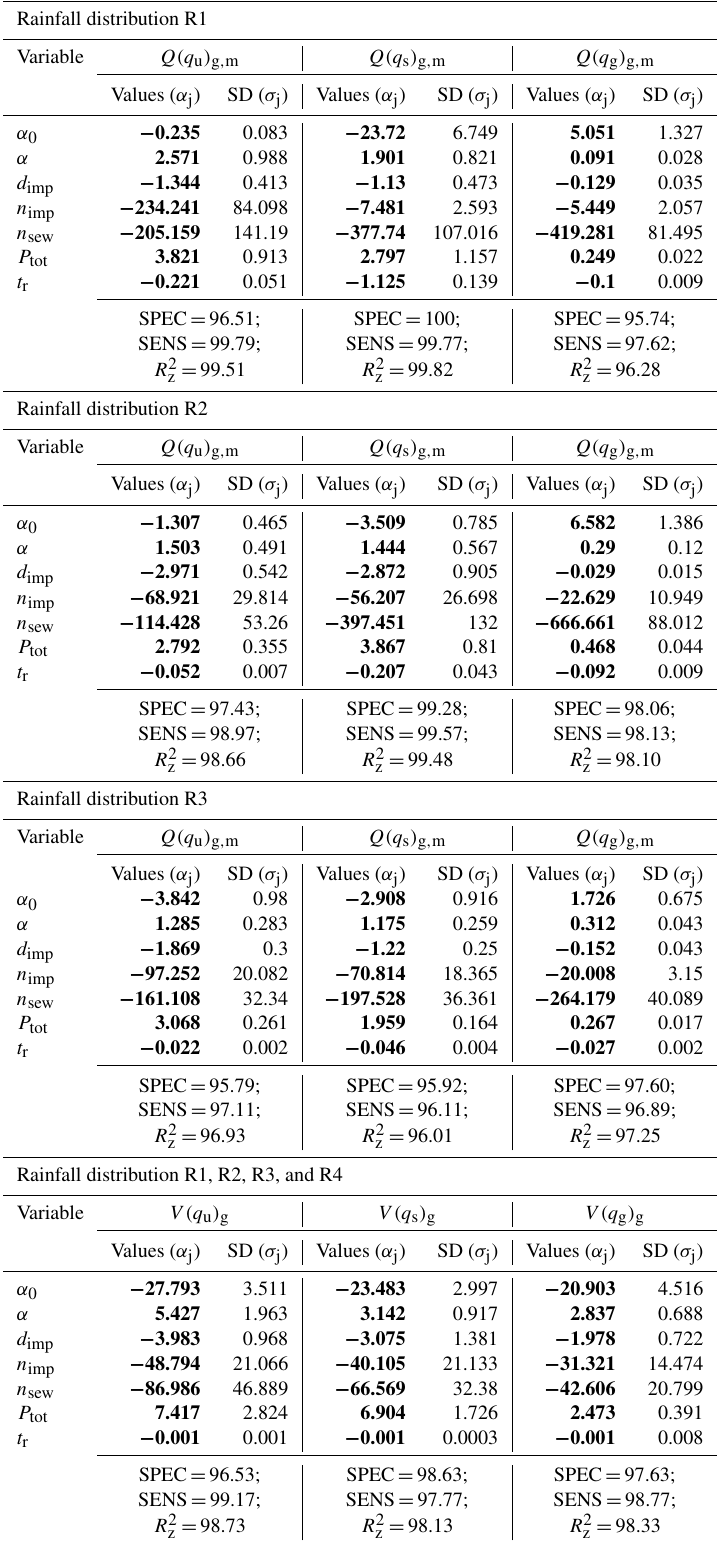
Table 2. Calculated coefficients ( α j ) and measures of the goodness of fit of measurement results to the logit model calculations of the Q g , m and V g values for rainfall distributions R1, R2, R3, and R4. Statistically significant parameters are in